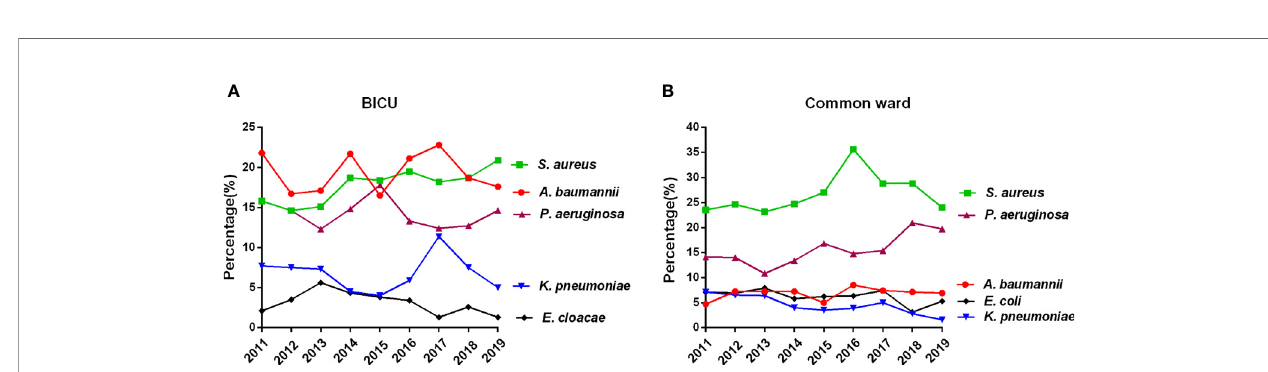
FIGURE 3 | Main pathogens in BICU and BCW. Changes of the fi ve most common pathogens in BICU (A) and BCW (B)